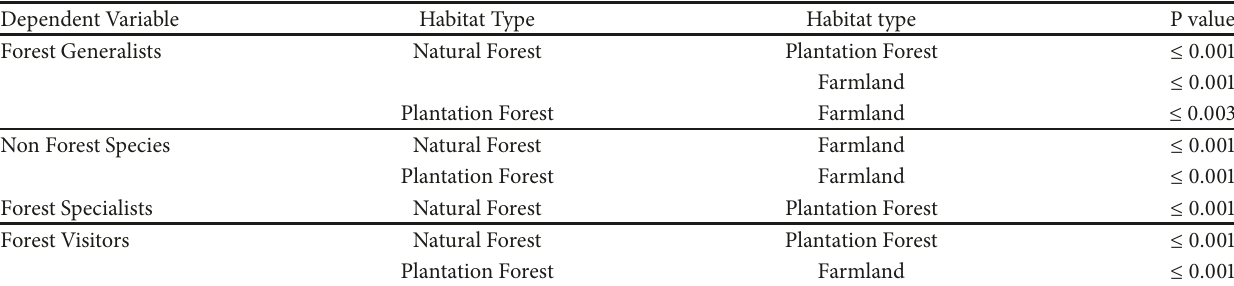
Table 1: Tukey’s HSD test significant